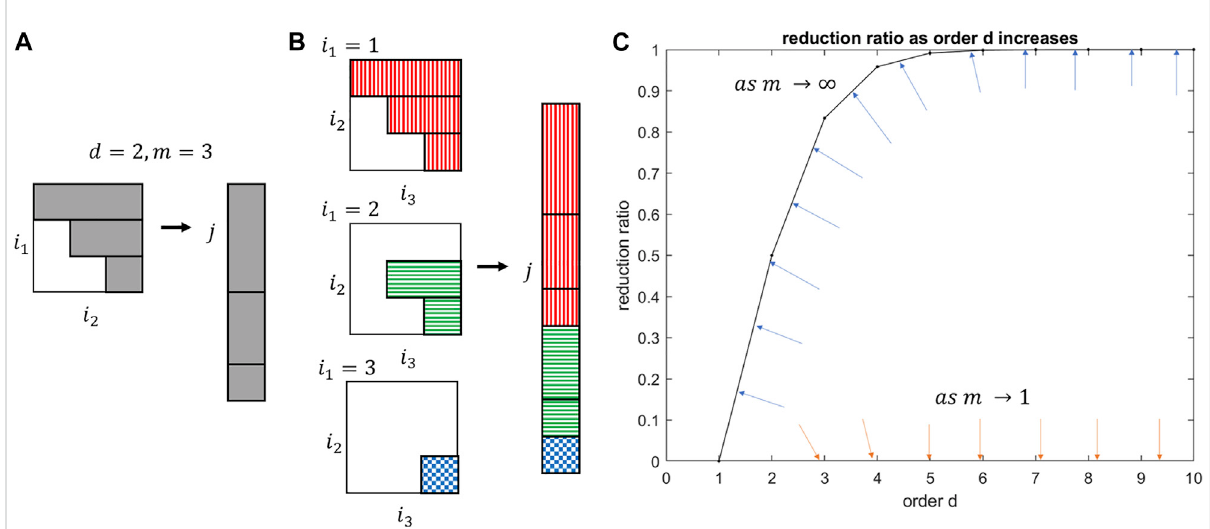
FIGURE 1 (A) Unfolding an upper triangular matrix into a vector. (B) Unfolding a tensor into a vector. (C) Reduction ratio between number of reductions andnumberoffullterms.Theblueandorangearrowsrepresentthemovementofthereductionratiocurveattwoextremes:blueasthestatevector dimension approaches in fi nity; orange as the state vector dimension approaches